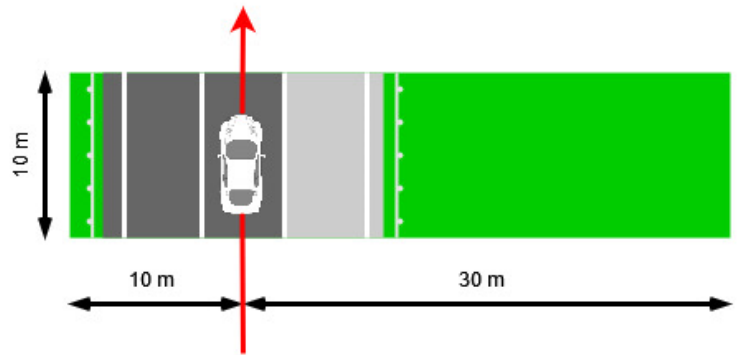
Figure 2. Example of one created road segment with appropriate dimensions. Red arrow represents driving direction, while black arrows represent dimensions of segment.